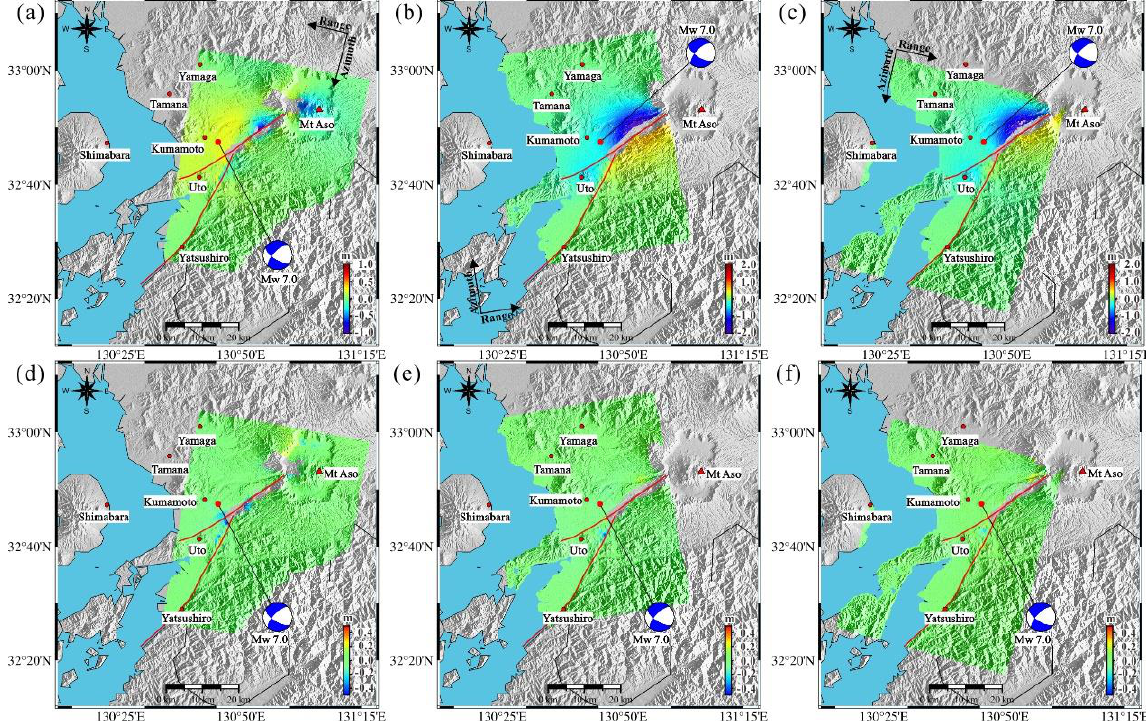
Figure 9. Prediction of coseismic surface deformation in InSAR LOS direction. ( a – c ) are respectively the modeled DR, AR, and DL InSAR deformation from the estimated slip model. ( d – f ) are the corresponding residuals between the observed and modeled displacements.